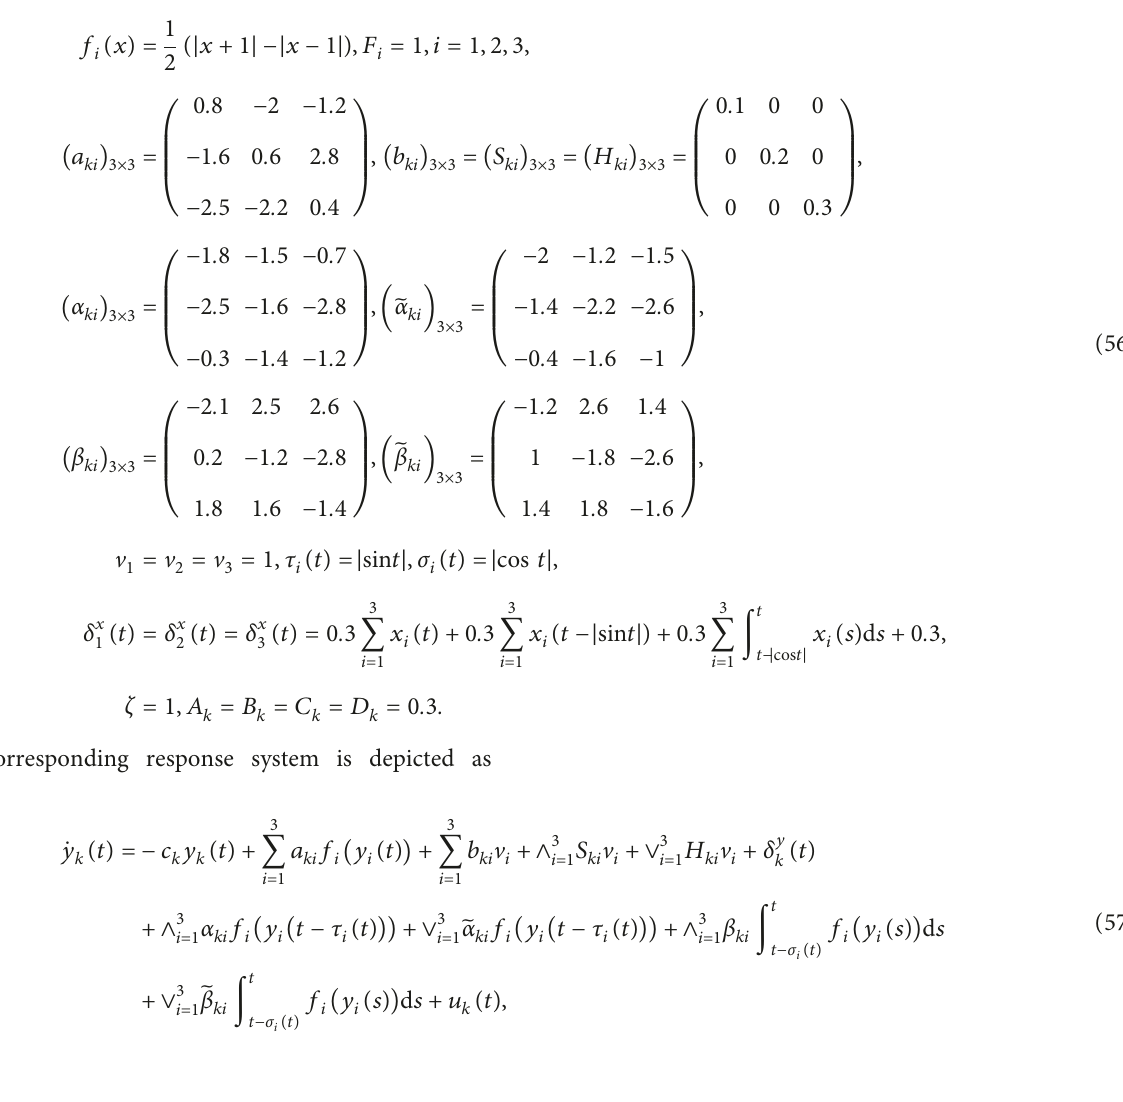
( t ) and e ( t ) for drive-response system under controller 1 2